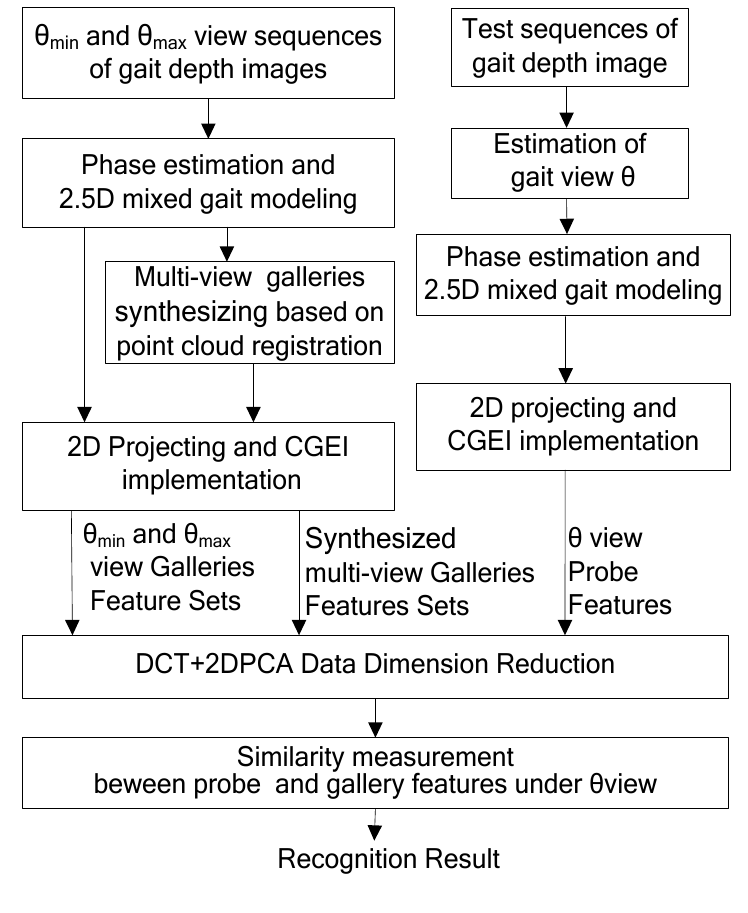
Figure 10. 2.5D view-invariant gait recognition method based on point cloud